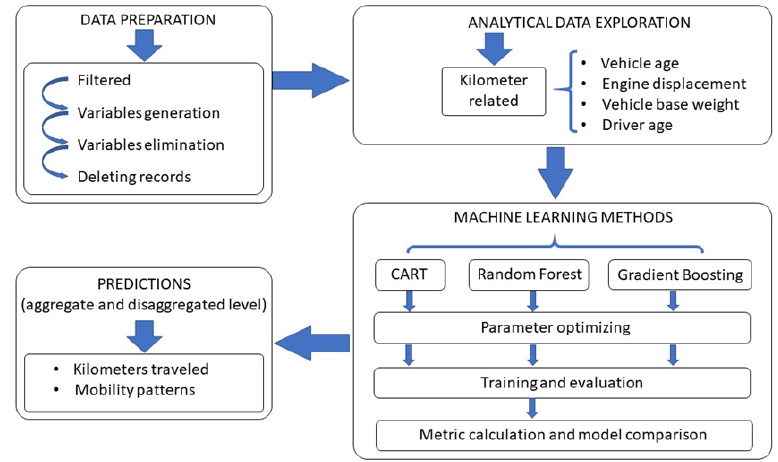
Figure 1. Analysis and prediction methodology.